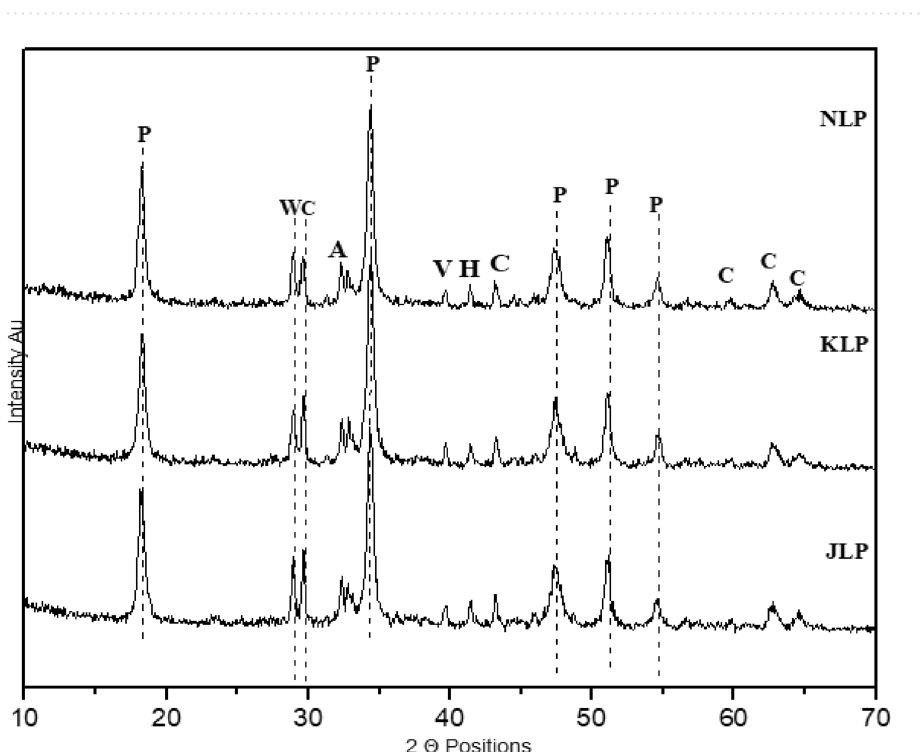
Figure 6. 7th day XRD results of organic lime putty—P: Portlandite, V: Vaterite, A: Aragonite, W: Weddellite, A: Aragonite, C: Calcite, H: Hatrurite: Neelamari lime putty, KLP: Kadukkai lime putty, JLP: Jaggery lime